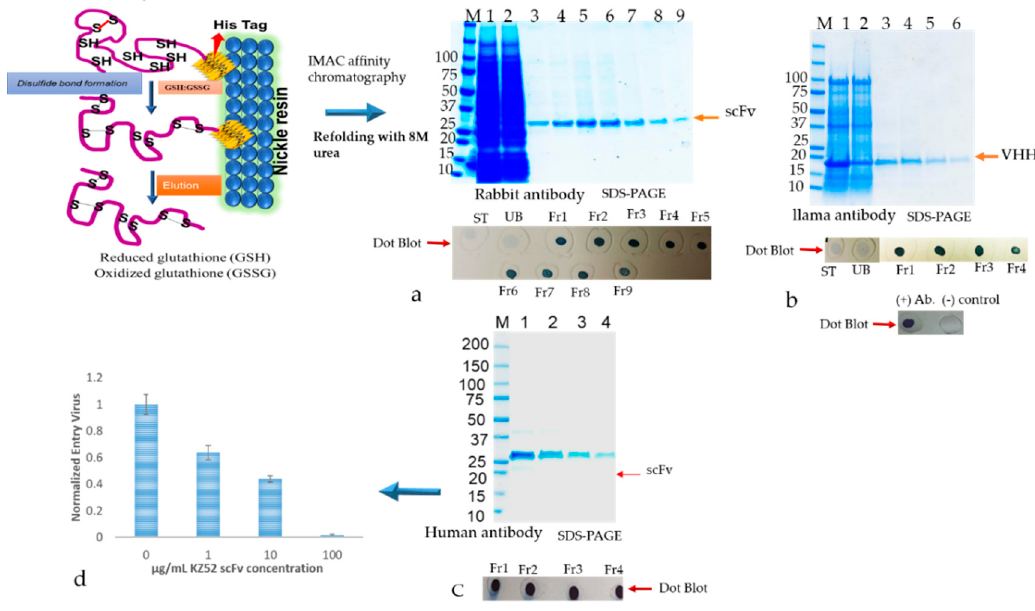
Figure 8. The affinity chromatography purification of scFv and VHH fragments using immobilized metal affinity chromatography (IMAC) after refolding of antibody fragments as described in method Section 2.9.2. ( a ) The refolded antibody fragment protein was subjected to IMAC as described in detail in the method section, and eluted fractions were analyzed using 4–20% gradient SDS-PAGE under reducing conditions. ( a – c ) Coomassie-stained SDS-PGE gel profile of purified refolded antibody fragments. Dot-blots are also shown at the bottom of the gel image. ( d ) Biological activity of the post-purified antibody, showing blockage of Ebola virus entry. The mean with standard deviation values of the ELISA were in triplicates. Lanes M indicates molecular weight, lanes 1–5 indicate purification fractions of Abs, respectively. ST represents starting material and UB represents unbound fractions. Fr indicates fraction. Ab (+) indicates control antibody. Ab ( − ) indicates PBS buffer.